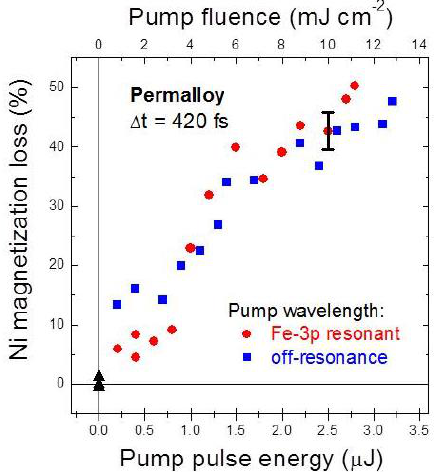
Figure 6. Ni magnetic response in permalloy. F dependence of the Ni magnetization loss in Py, 420 fs after the pump pulse. The red circles and blue squares refer to 53.5 eV Fe-3p resonant and to 48.6 eV non-resonant pump pulses, respectively. The pump fluence at the sample (top scale) is estimated from the pump intensity measured at the exit of the source (bottom scale). The Ni magnetization loss represents the decrease in the asymmetry ratio signal at the Bragg peak with respect to the non-pumped condition (black triangles). The black vertical bar corresponds to one standard deviation in the value of the measured magnetic signal.